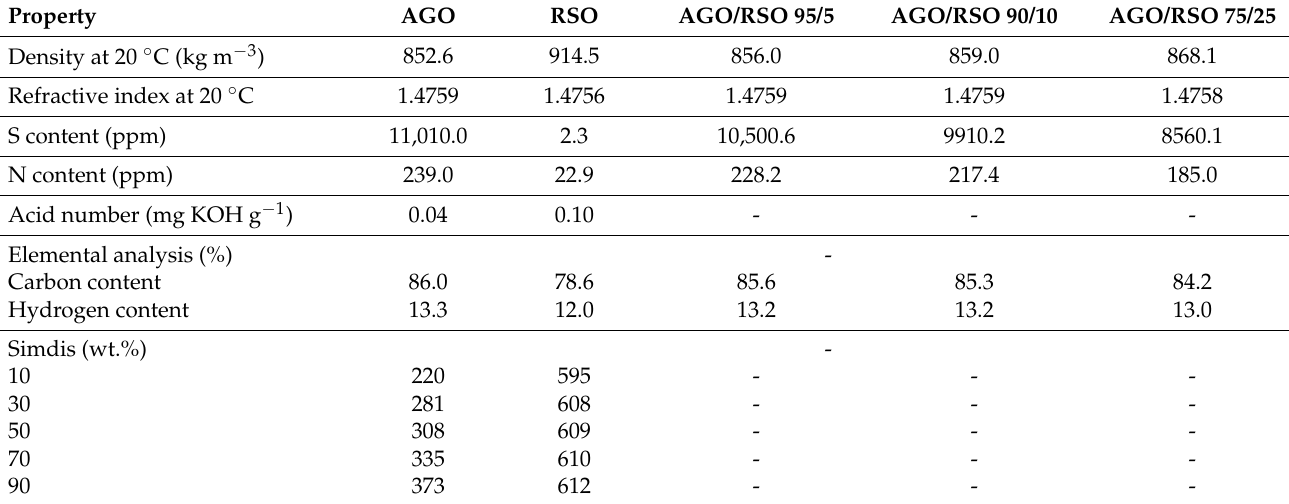
Table 3. Characterisation of used feedstocks for processing and